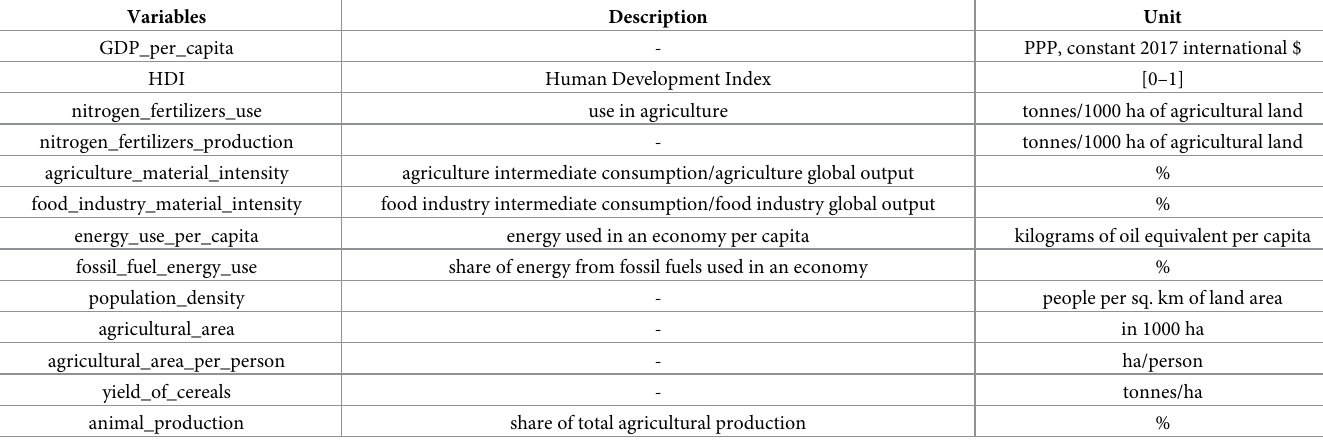
Table 1. Variables used to estimate the panel regression